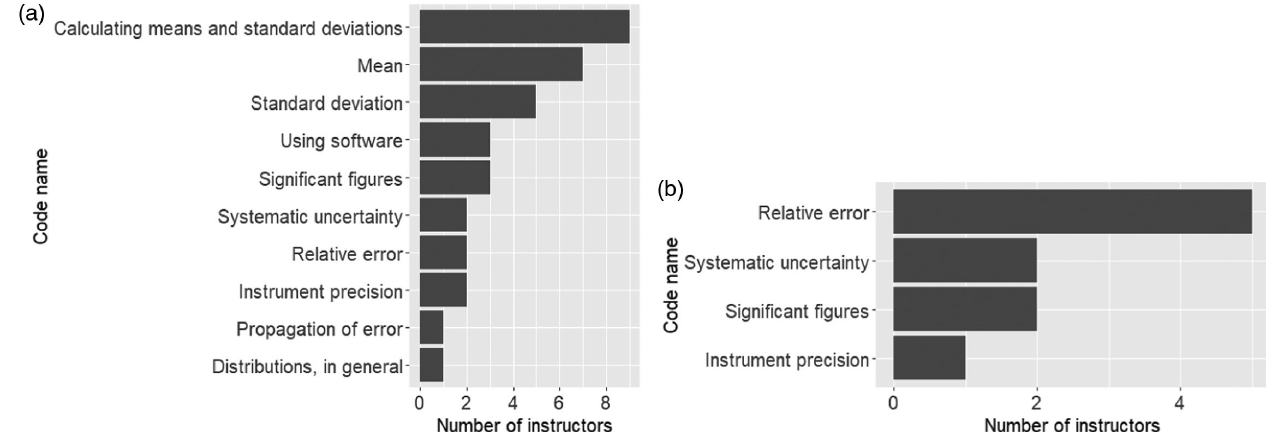
¼ 22 ) in which instructors mentioned topics students already know, separated by whether these FIG. 4. The number of interviews ( N tot topics supported (a) or hindered (b) learning, broken down by the emergent codes in Tables IV and